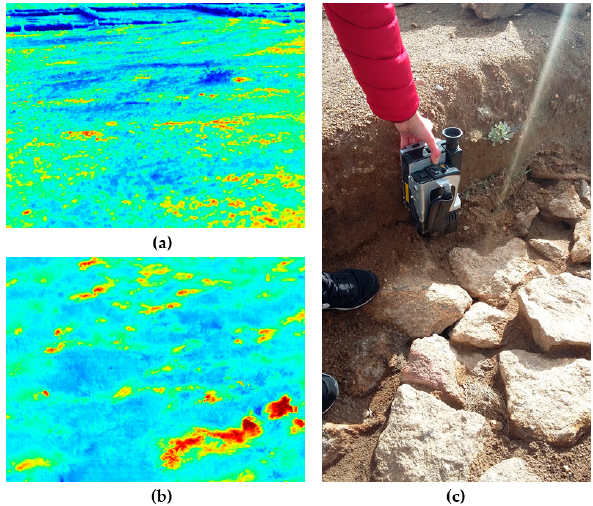
Figure 10. ( a ) Thermographic image of the terrain, showing a possible grid pattern of high temperatures; ( b ) thermographic image of a detail of the terrain, where high temperatures are associated with a lack of vegetation; ( c ) visual demonstration of the depth of the top of the walls, from a wall partially